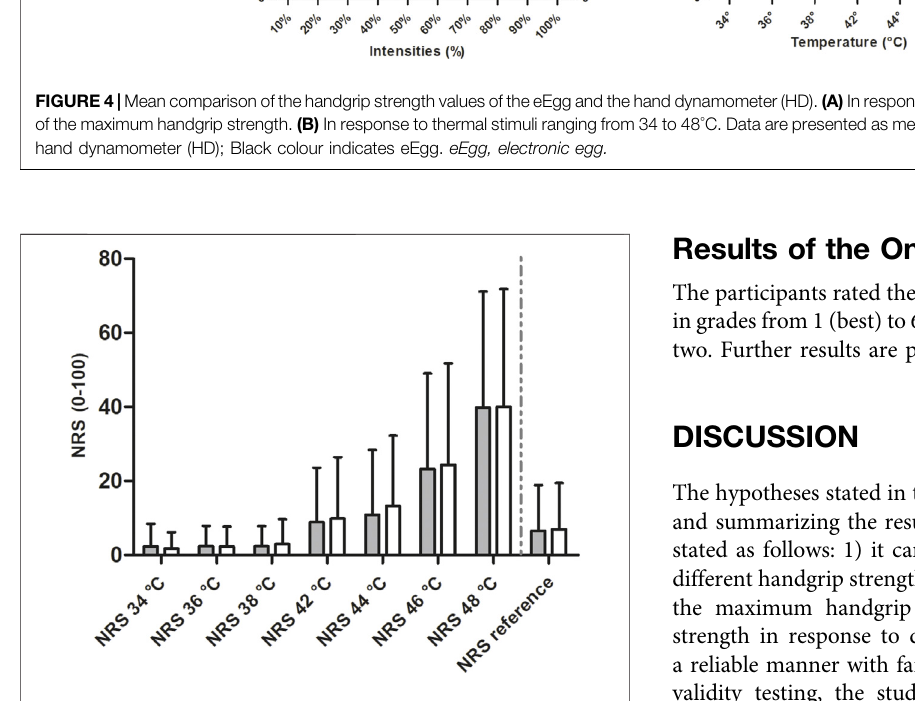
FIGURE5| ComparisonoftheNRSvaluesresultingfromthermalstimuli during the second experimental test employing the hand dynamometer (grey fi lling) and the eEgg (white fi lling), respectively. Data arepresented asmeans ± standard deviation. No signi fi cant difference is observed between the NRS values. NRS, Numerical Rating Scale; eEgg, electronic